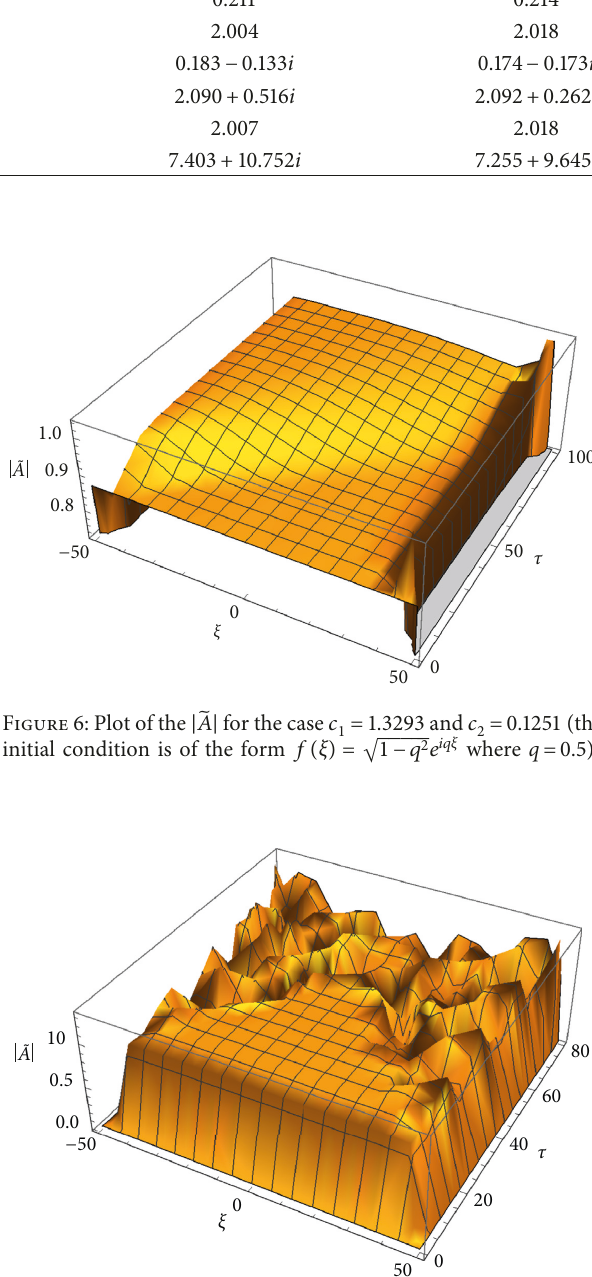
Figure 7: Plot of the | 􏽥 A | for the case c � c 2